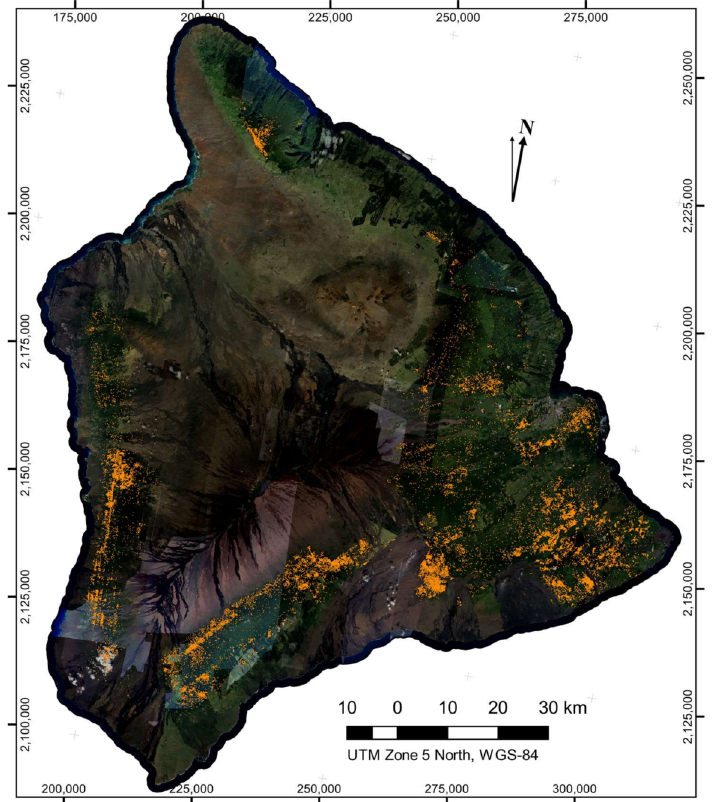
Figure 5. Map of the brown-state ‘¯ohi‘a crowns detected using our modeling and filtering approach applied to the CAO coverage of Hawaii in June 2017. Individual points represent single detections of 8 m 2 or greater. For visibility, individual points are 120 m in diameter at this map scale. Therefore, denser clusters of detected crowns appear as contiguous regions on the map. Background imagery from Google, DigitalGlobe